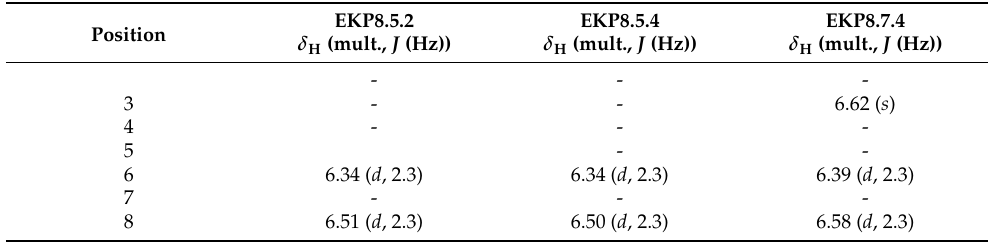
Table 1. 1 H NMR data (CDCl 3 , 400 MHz) of 3,5,7-trimethoxyflavone (EKP 8.5.2), 3,5,7,3 (cid:48) ,4 (cid:48)